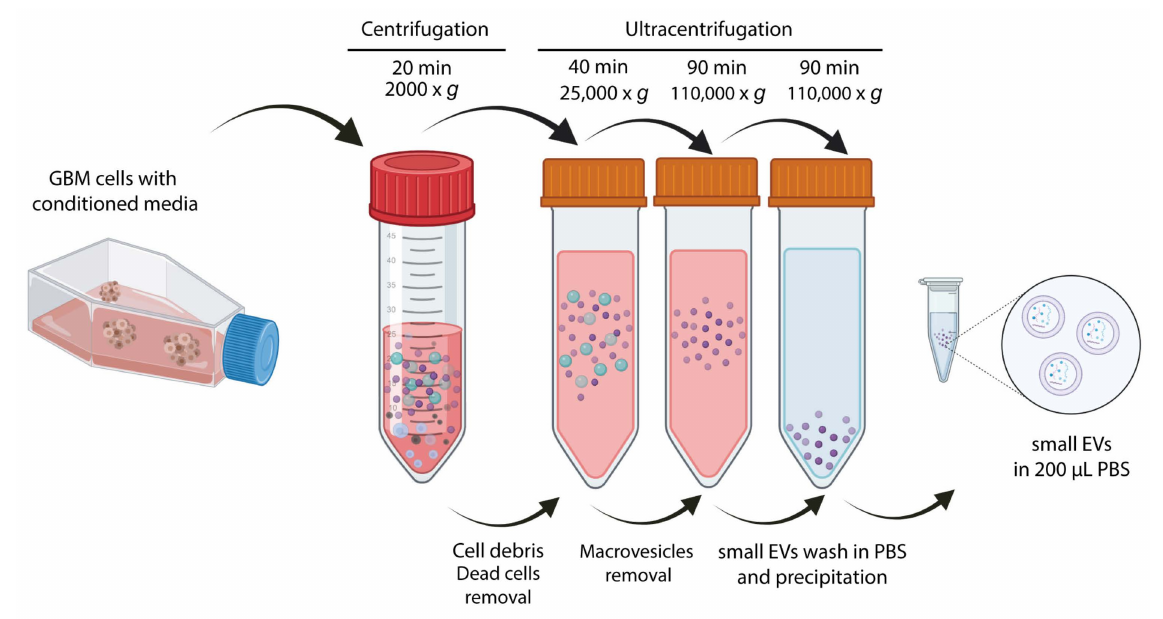
Figure 2. Scheme representing GBM-derived small EVs isolation. Sequential steps of centrifuge and ultracentrifuge were performed, as indicated on top of the arrows. GBM, glioblastoma; EVs, extracellular